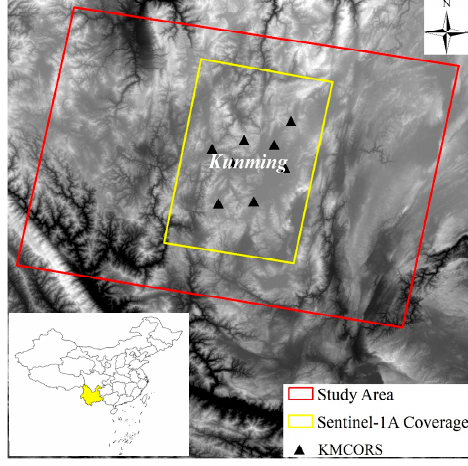
Figure 2. SAR data coverage of the study area.